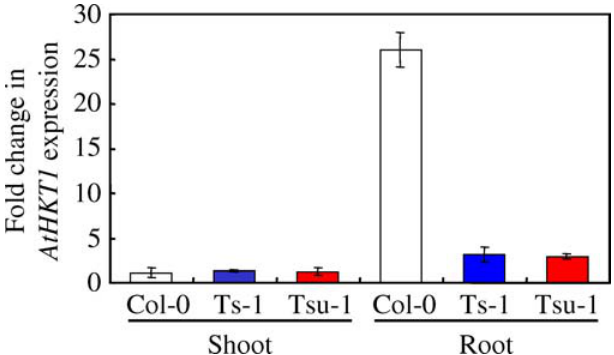
Figure 4. Root Differential At HKT1 Expression between Col-0, Ts-1, and Tsu-1 At HKT1 level of expression was compared in shoots and roots of Col-0, Ts-1, and Tsu-1 plants. RNA was isolated from shoot and root of 60-d-old plants grown in soil under short-day conditions. For normalization across samples, the expression of the Actin 1 gene was used, and relative fold induction was calculated in comparison to At HKT1 expression in Col-0 shoot using the DD C t method. Presented data are the means of at least three biological replicates, and the error bars represent 6 SD.